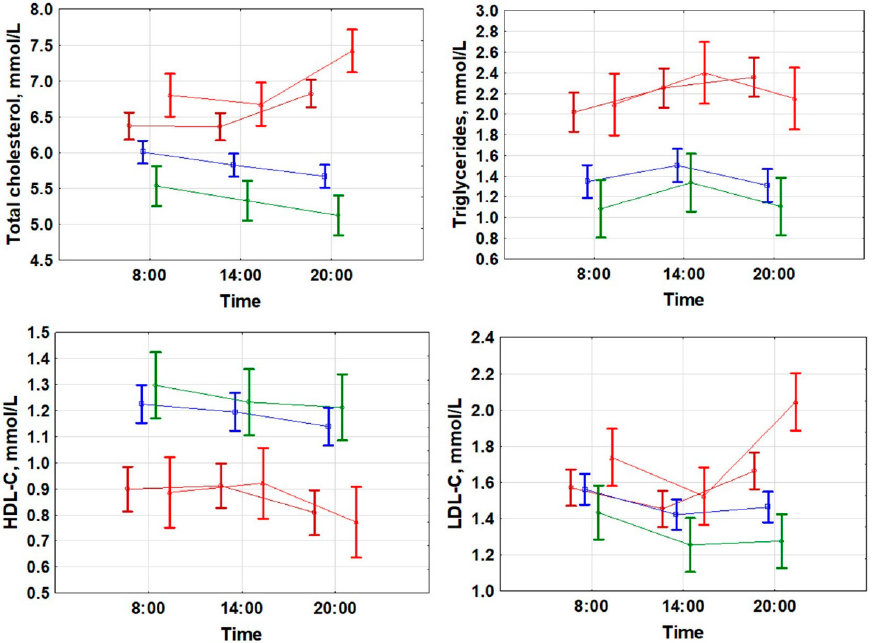
Figure 2. Daytime patterns of lipid metabolism in glaucoma patients with different degrees of retinal ganglion cell (RGC) loss, assessed as two-eye mean global loss volume (GLV%), gauged by high-definition optical coherence tomography. n = 114; RGC GLV < 5%, n = 16; GLV = 5–10%, n = 49, GLV = 15–25%, n = 35; n > 25%, n = 14). Effects for time–group interaction: total cholesterol: F (6, 330 ) = 6.267, p < 0.0001; triglycerides: F (6, 330) = 1.006, p = 0.421; high-density-lipid cholesterol,